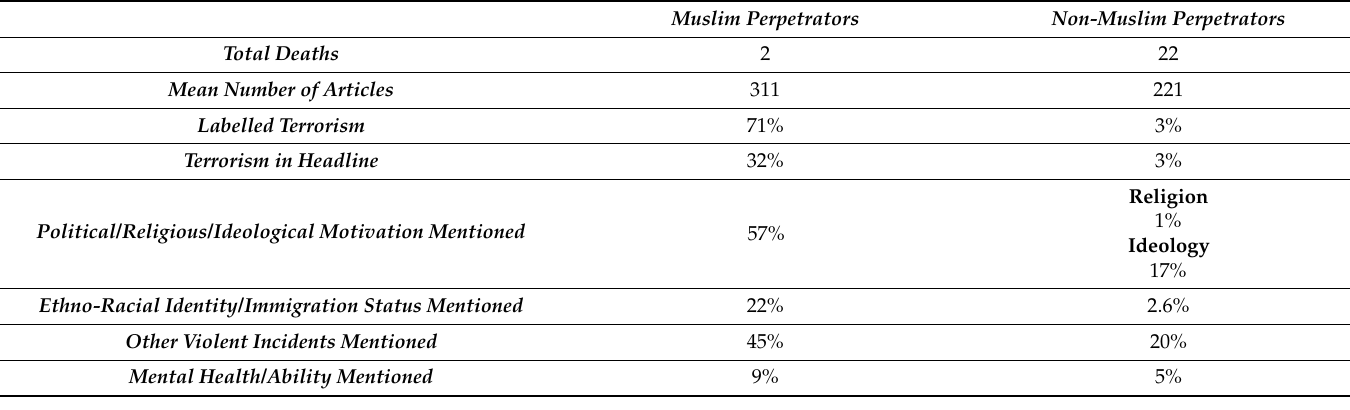
Table 3. Comparison of Coverage—Incidents with Muslim versus Non-Muslim